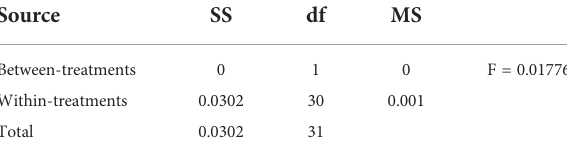
TABLE 1 Advanced test results of ANOVA.